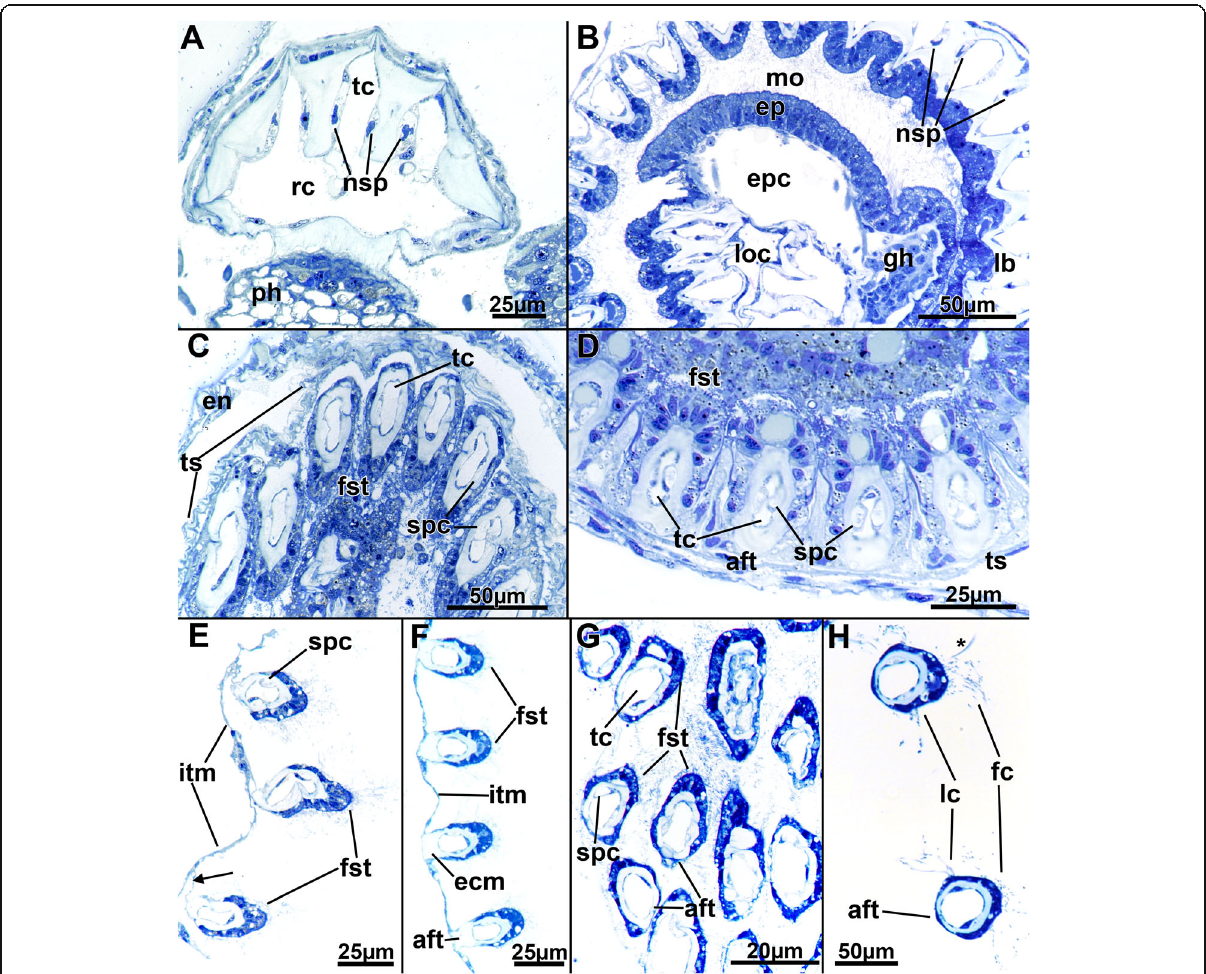
Fig. 8 Histological details of the tentacles of Stephanella hina . Semithin sections. a Longitudinal section of the oral lophophoral base through the ring canal showing extension from the ring canal into the oral tentacles and longitudinally sectioned nuclei of the subperitoneal cells of the tentacles. b Slightly oblique cross-section of the lophophoral base. The tentacles on the right side are more proximal, with the tentacle coelom still embedded in a common extracellular matrix, whereas the sectioned tentacles on the left show individual tentacles already. The nuclei of the subperitoneal cells are visible on the right side. c Cross-section of retracted tentacles within the tentacle sheath. Note also the subperitoneal cells medially occluding the tentacle coelom in some areas of the retracted positions (right side of the image). d Close-up of cross-sectioned retracted tentacles showing subperitoneal cells bulging medially towards the tentacle coelom in the longitudinal axis of each tentacle. e & f Cross-sections of extended lophophores showing different attachment possibilities of the tentacles to the intertentacular membrane via thin pedicels ( e ) or with the abfrontal side of the tentacles completely integrated into the membrane ( f ). ( g & h ) Cross-sections of densely arranged tentacles ( g ) with a thin epidermal layer always present on the abfrontal side and a thicker epidermal layer on the frontal side. Cilia are mainly located on the lateral and frontal sides of the tentacles ( h ). Note a thick cilium (asterisk) extending from the upper tentacle in ( h ), possibly a latero-frontal